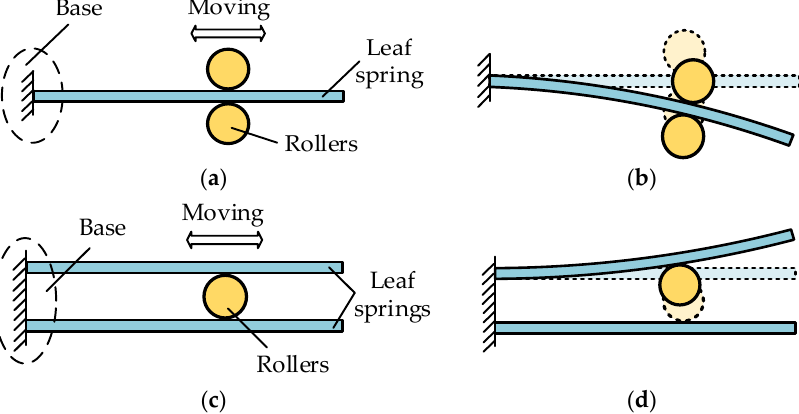
Figure 1. Two arrangements of leaf springs and rollers. ( a ) Single leaf spring and double rollers arrangement (initial state). ( b ) Single leaf spring and double rollers arrangement (transmission state). ( c ) Double leaf springs and single roller arrangement (initial state). ( d ) Double leaf springs and single roller arrangement (transmission state).